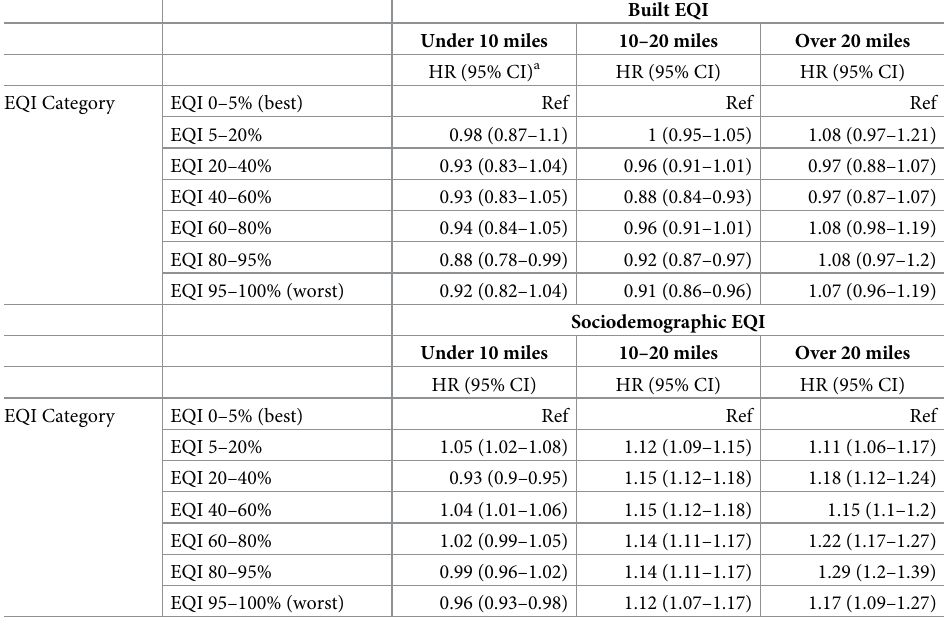
Table 4. Hazard ratios for ESRD and built and sociodemographic EQI domain stratified by distance to the nearest hospital (1,092,281 patients,